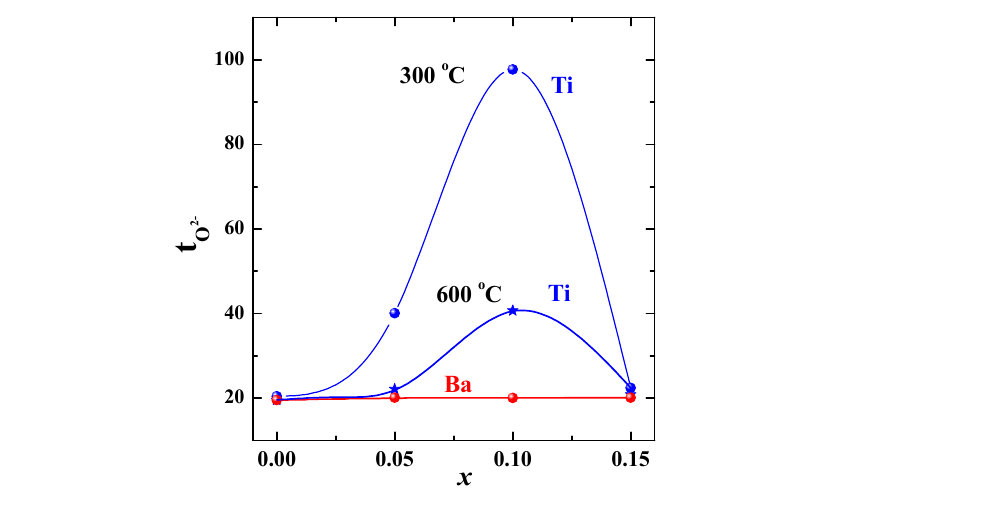
Figure 14. The concentration dependencies of oxygen-ionic transport numbers for the solid solution Ba 1+ x La 1 − x InO 4 − 0.5 x (red) [79] at 600 °C and for the solid solution BaLaIn 1 − x Ti x O 4+0.5 x (blue) [80] at 300 and 600 °C.